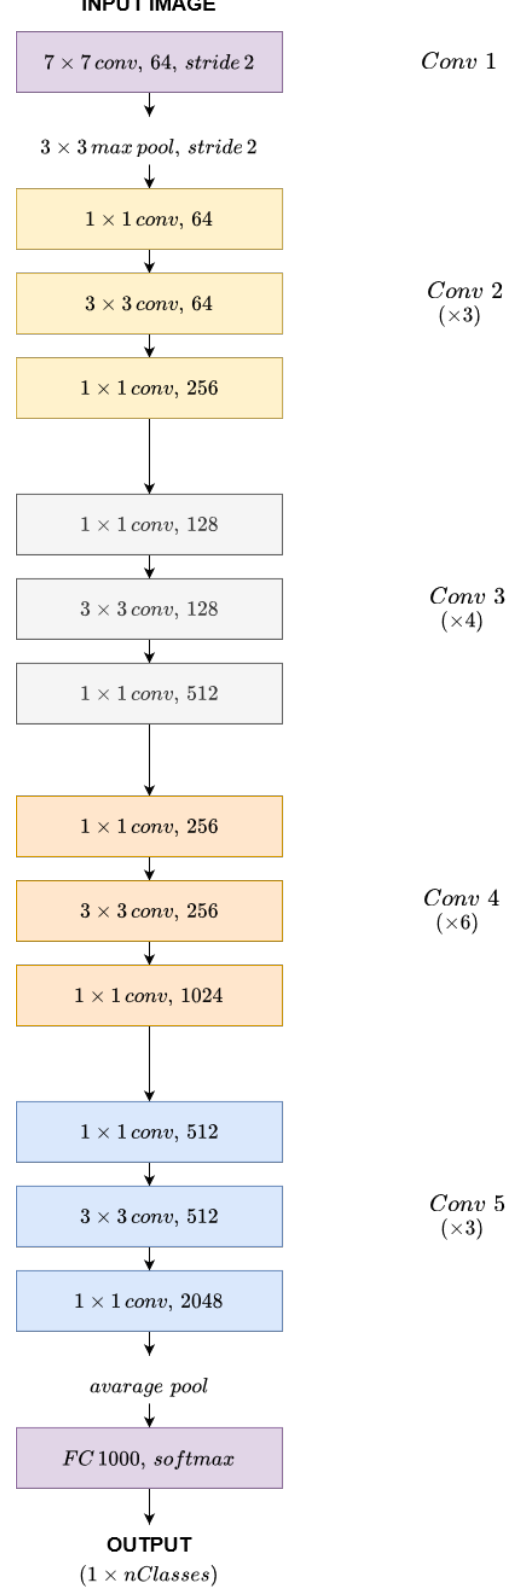
Figure 4. ResNet50 architecture.